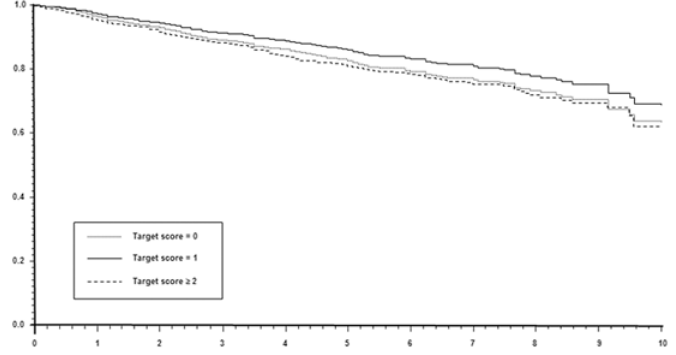
Fig 1. Survival adjusted curves from fully-adjusted multivariable Cox regression, according to the various groups of target